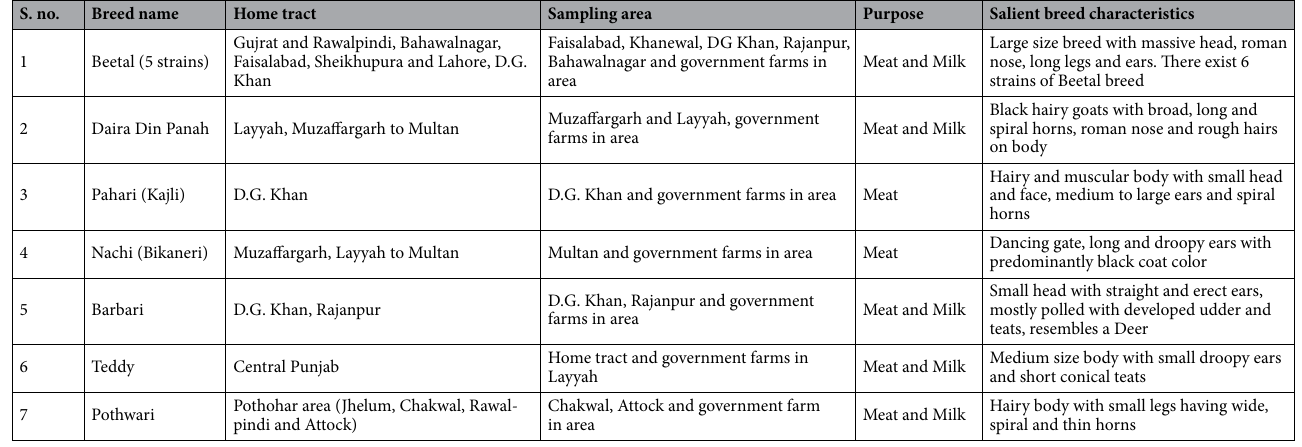
Table 3. Goat breeds of Punjab with their home